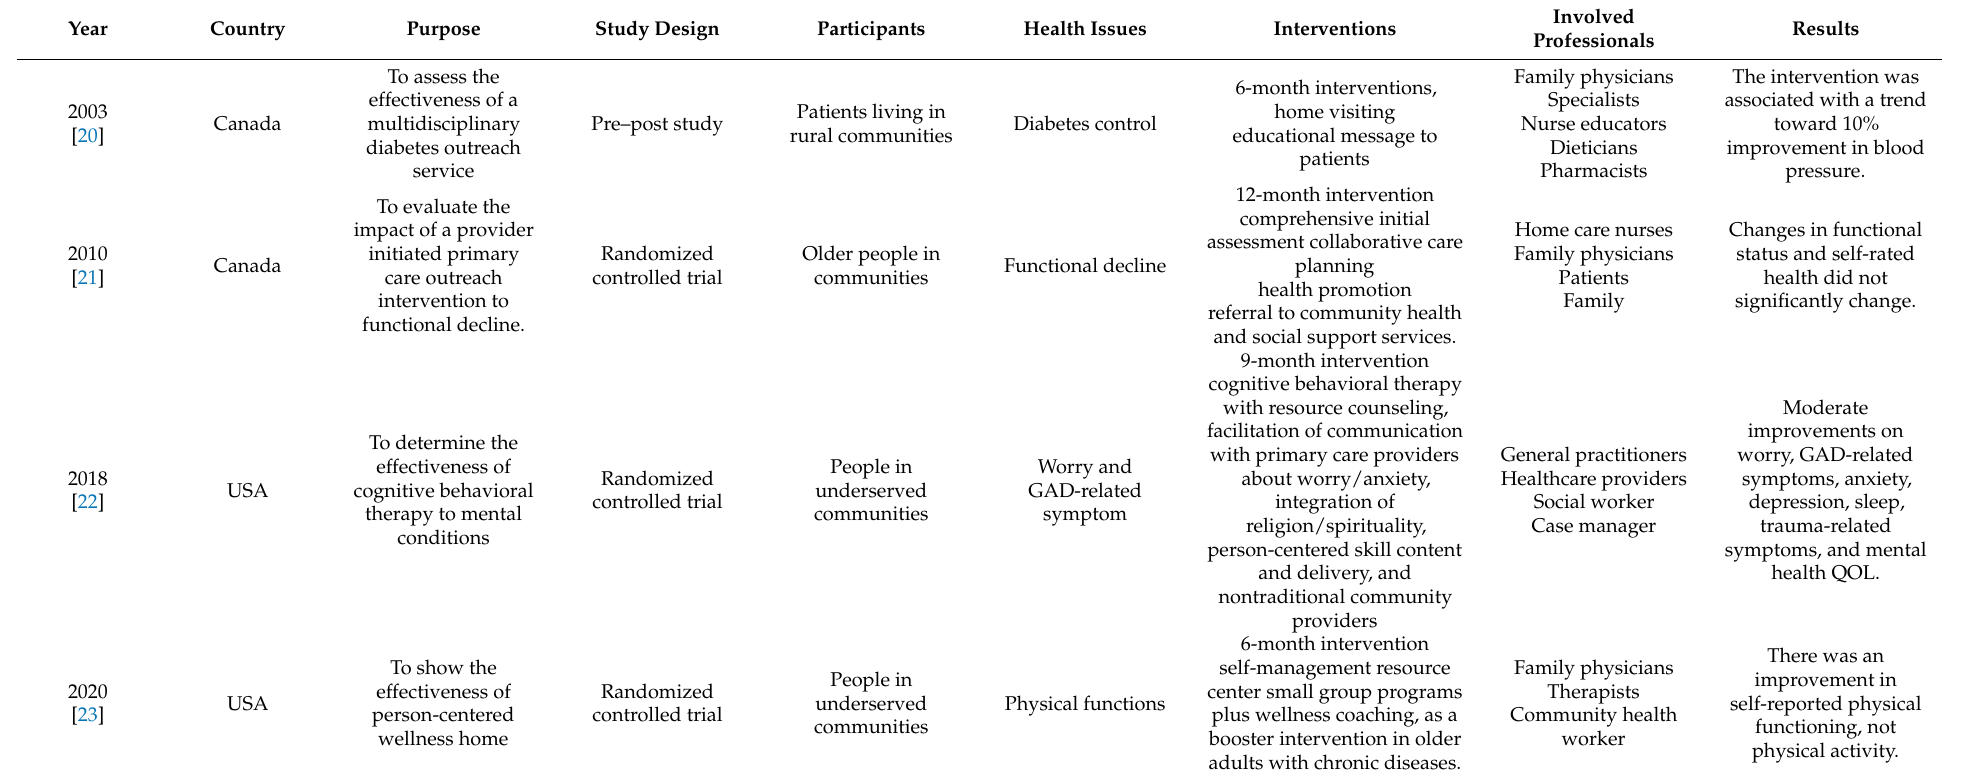
Table 2. Studies included in the